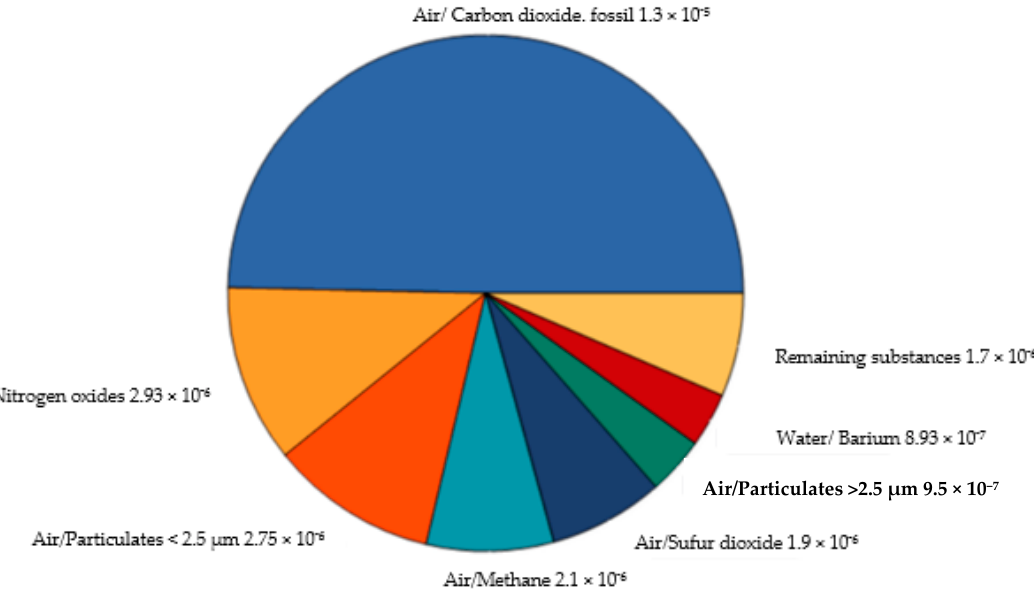
Figure 5. Emissions contributed to the human health damage assessment of 1 kg of SPF-reinforced sago starch composite takeout food container analyzed (damage assessment/excluding long-term emissions).